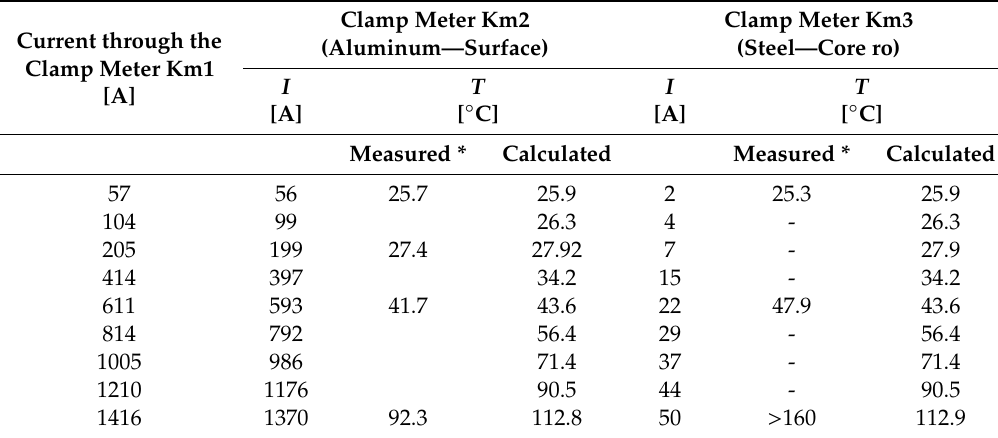
Table 3. Measured and calculated currents and temperatures at parallel binding of steel core and aluminum coat.